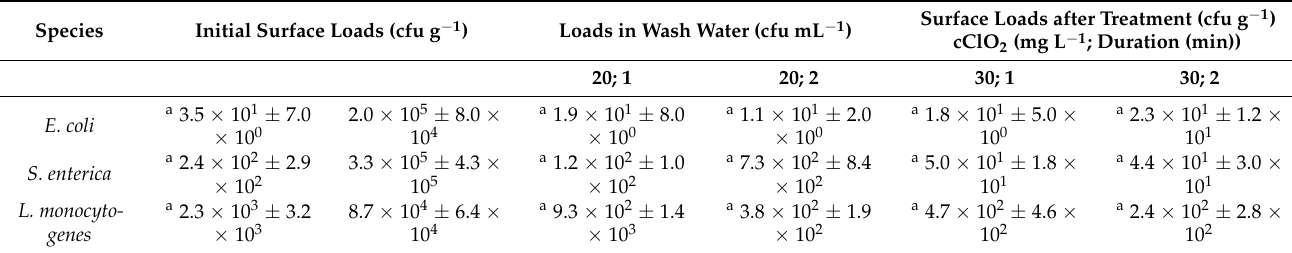
Table 2. Efficacy of adding various concentrations of ClO 2 to contaminated ( E. coli , S. enterica, L. monocytogenes ) washing water (COD 350 mg L − 1 ) to prevent the cross-contamination of iceberg lettuce leaves.